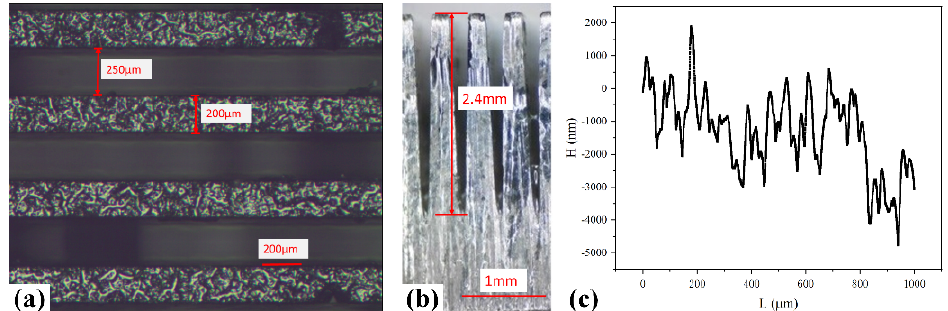
Figure 3. The details of the microchannel structure. ( a ) Top-view OM photography of the diamond microchannel. ( b ) Cross-section OM photography of the diamond microchannel. ( c ) Surface roughness of the microchannel inner wall.